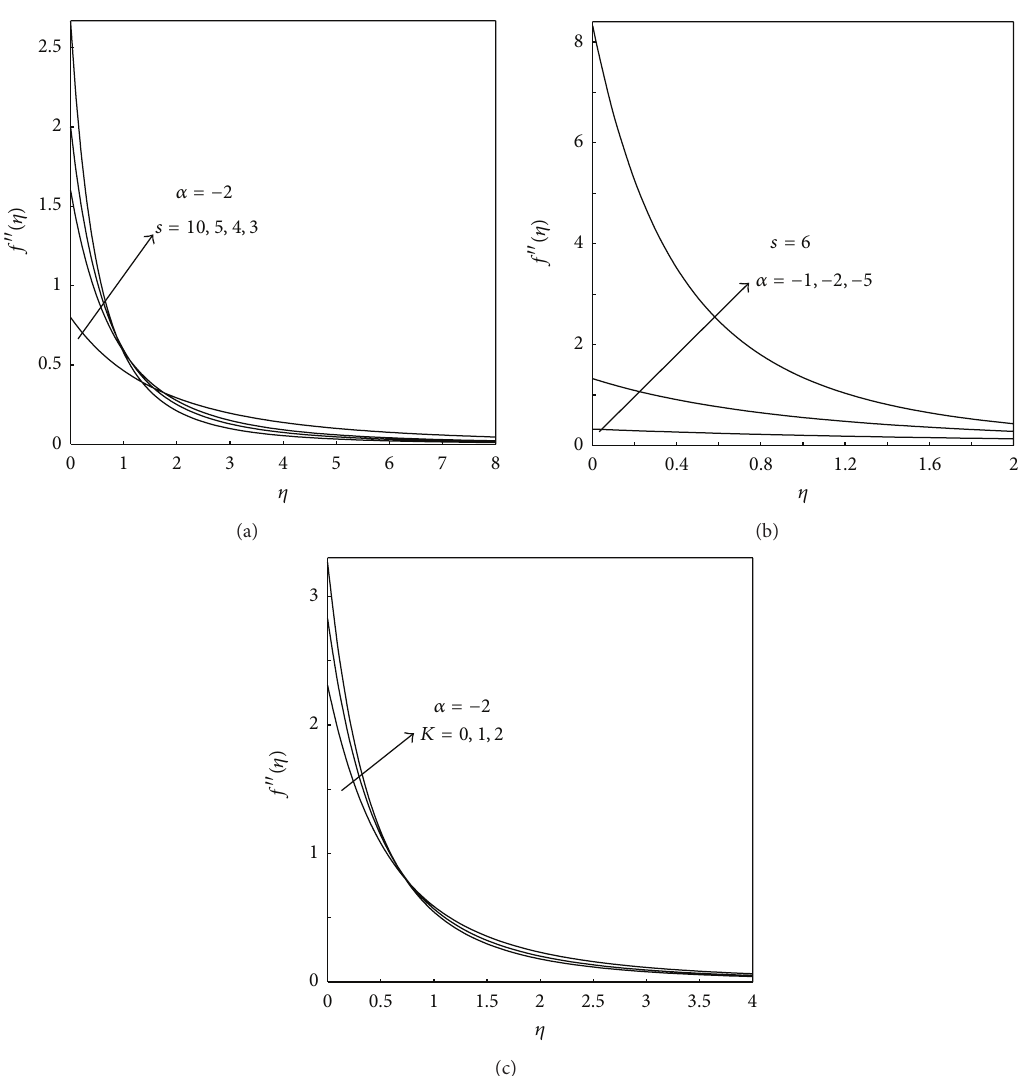
Figure 5: (a) Shear stress profiles for a shrinking sheet under different values of mass suction parameter. (b) Shear stress profiles under different values of shrinking sheet strength with mass suction. (c) Shear stress profiles for a shrinking sheet under different values of permeability